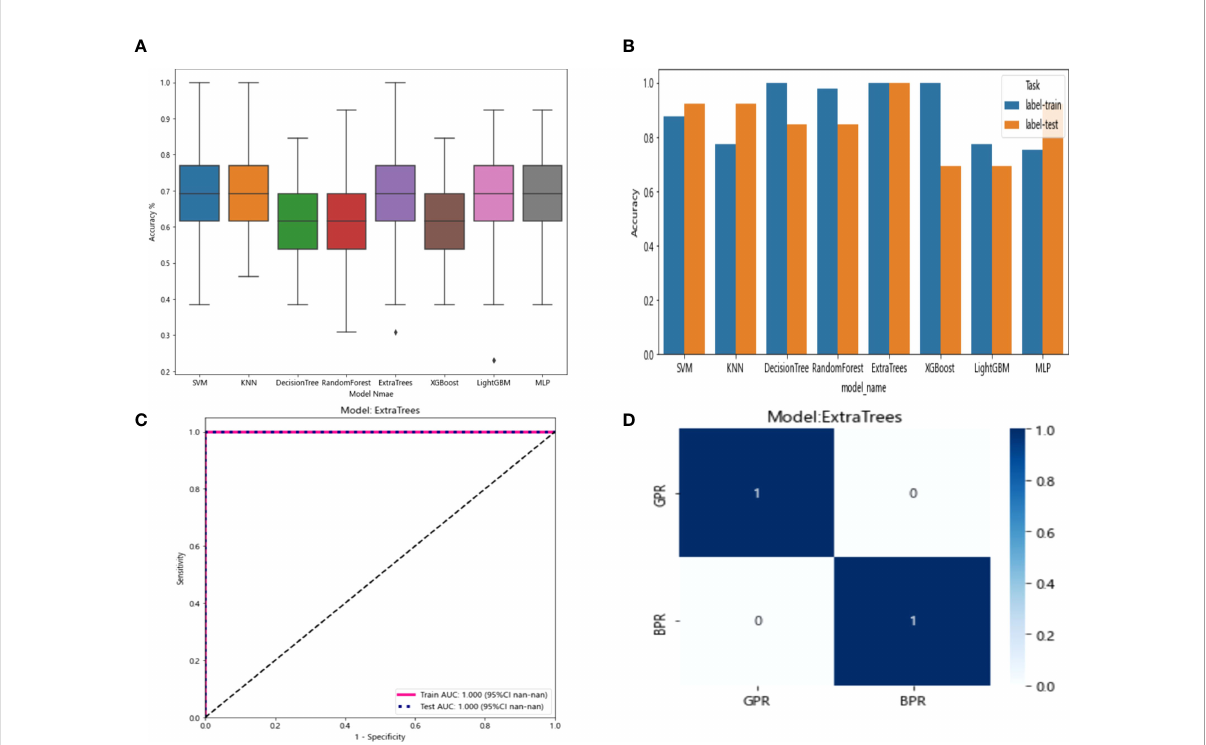
FIGURE 7 (A) Distribution of the accuracy of each model randomly tested 100 times by eight common machine learning algorithms. (B) Comparison of the accuracy of the best performing one out of 100 randomizations in eight machine learning algorithms. (C) AUCs of the training set and test set in the Extratrees model. (D) Confusion matrix for the Extratrees